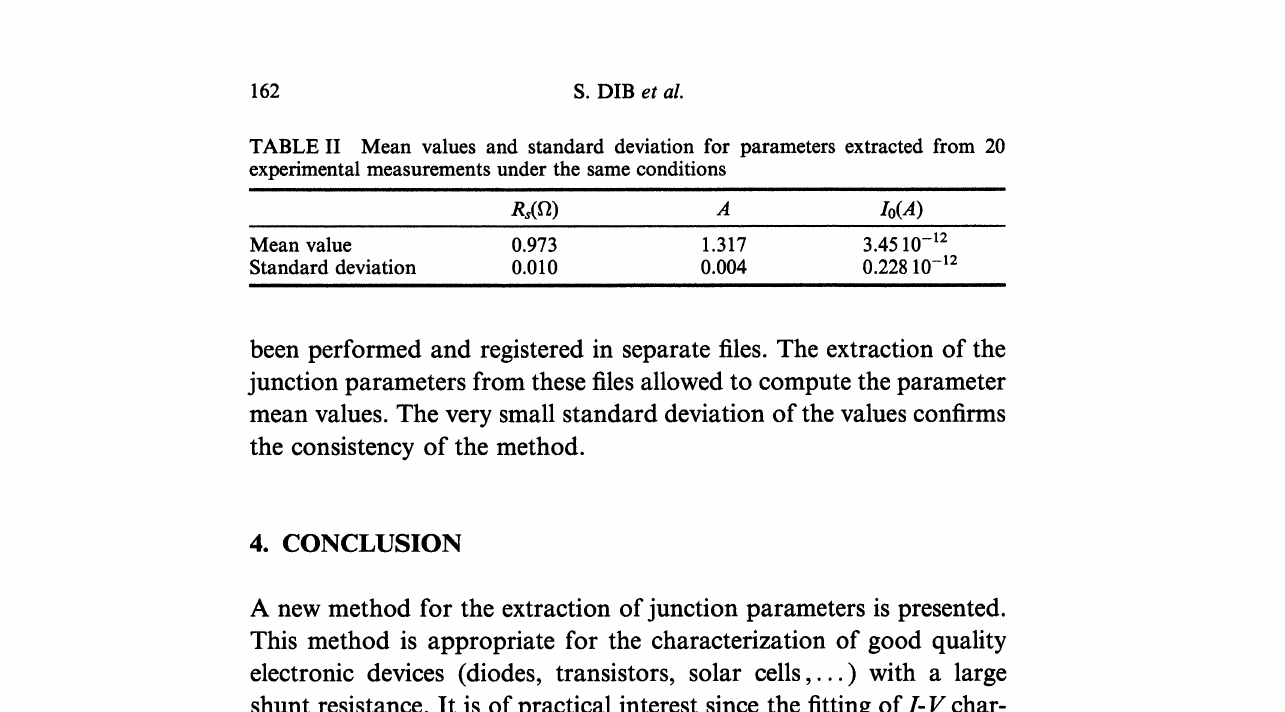
TABLE II Mean values and standard deviation for parameters extracted from 20 experimental measurements under the same